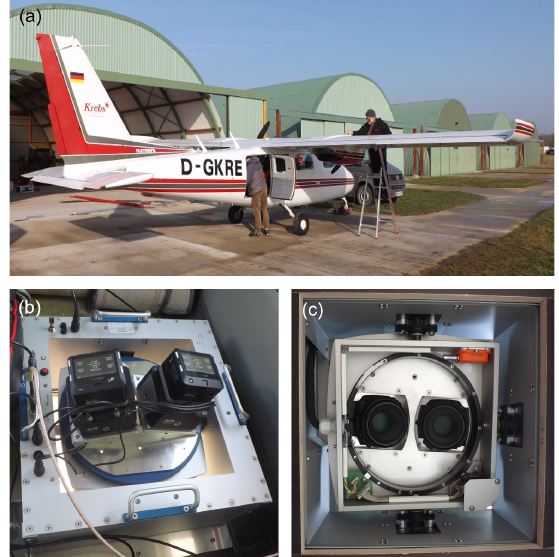
Figure 2. (a) Equipping a twin-engine aircraft for aerial digital surveys of marine wildlife, (b) View of a crosswise mounted tandem camera (PhaseOne IXA180) within a gyroscopically stabilized platform (GGS Speyer), (c) Exterior view of the camera system through the hatch of the